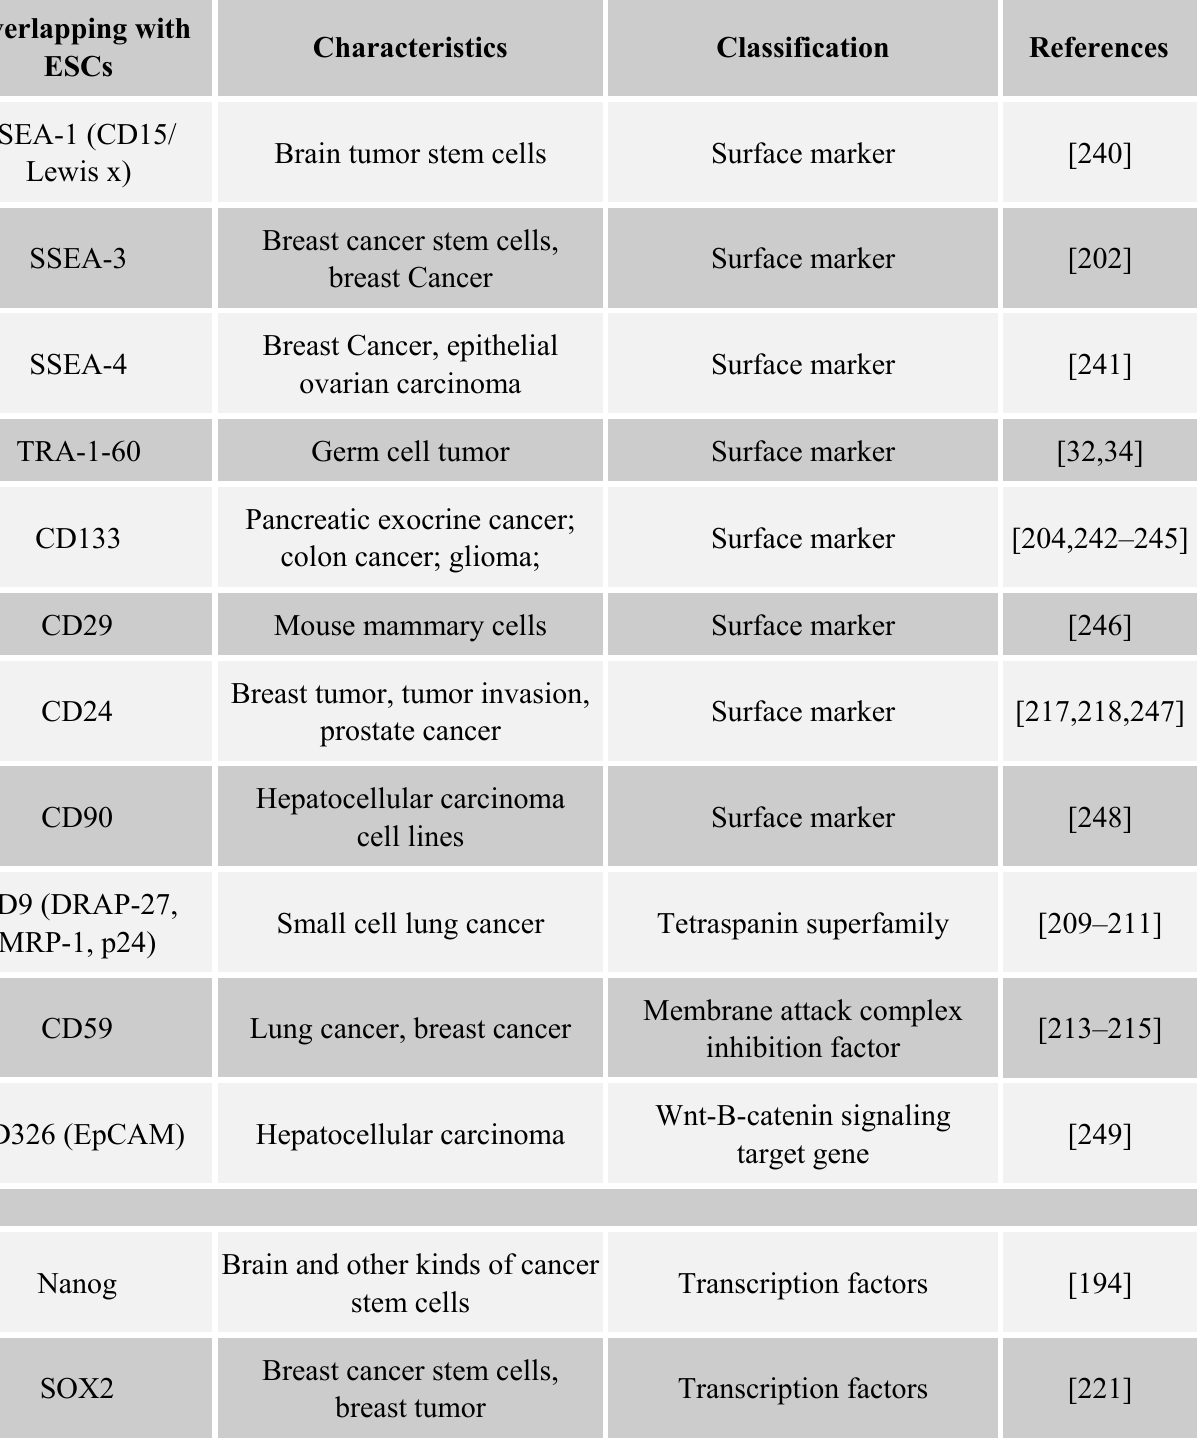
Table 5. Tumor stem cell